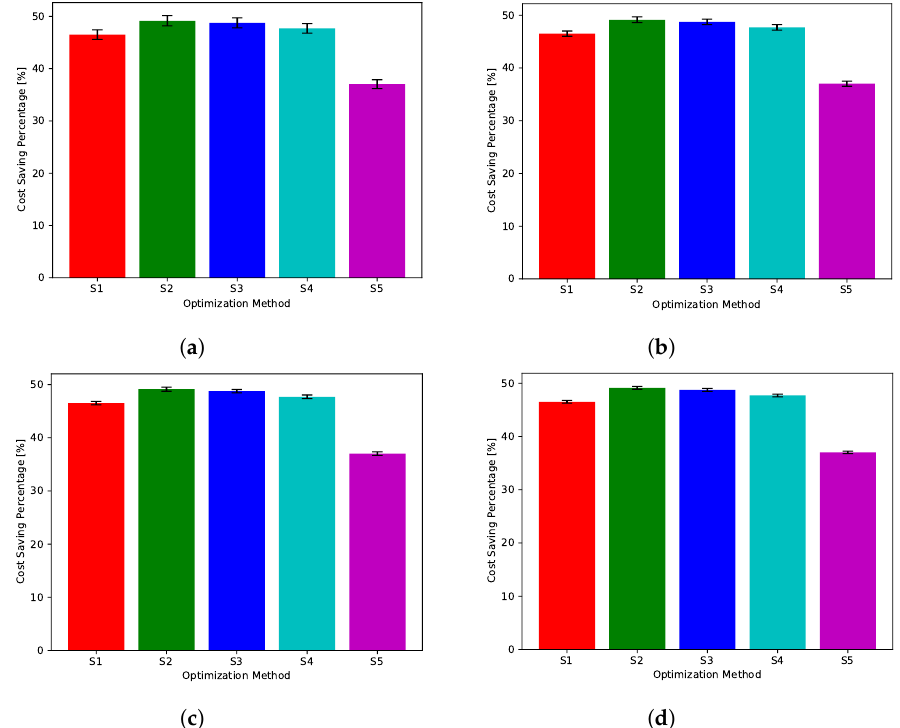
Figure 27. The total cost saving achieved by the proposed greedy scheduler when compared with scheduling policies fixed uncertainty level U 95 . ( a ) Monthly, ( b ) quarterly, ( c ) semiannually, and ( d )